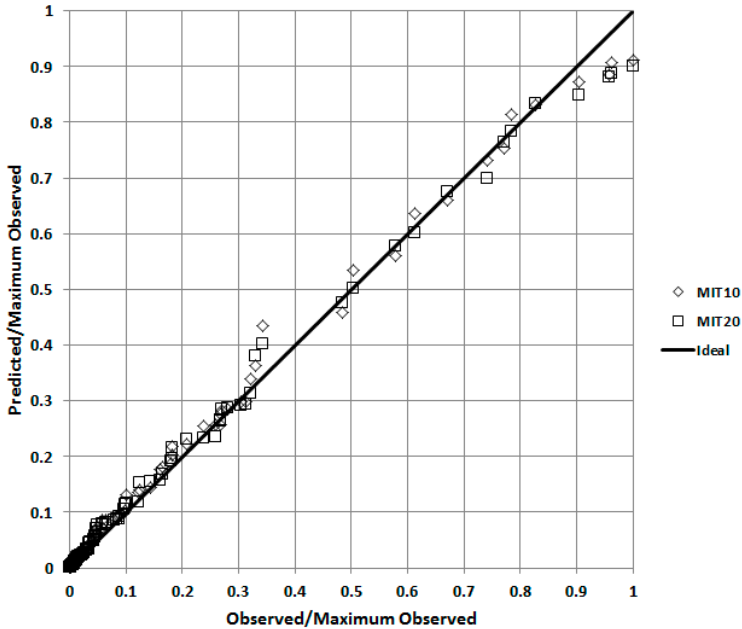
Figure 4. Quantile–quantile plot comparing predictions from UDM against observed concentrations for release 49 of Prairie Grass, for two different meteorological inputs MIT10 and MIT20.